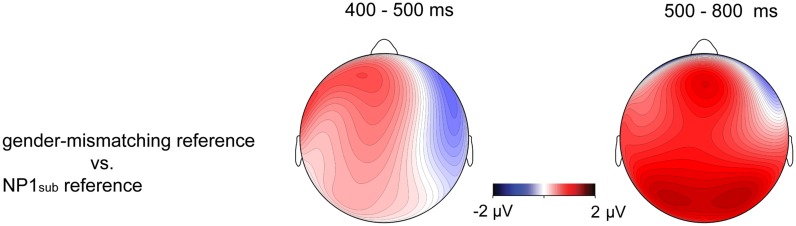
Topographic maps for difference waves on the pronoun in Experiment 1 between the NP1sub reference (gender-matching reference with SVO structure) and the gender-mismatching reference (with SVO structure) in 400–500 ms window (left) and 500–800 ms window (right), respectively.